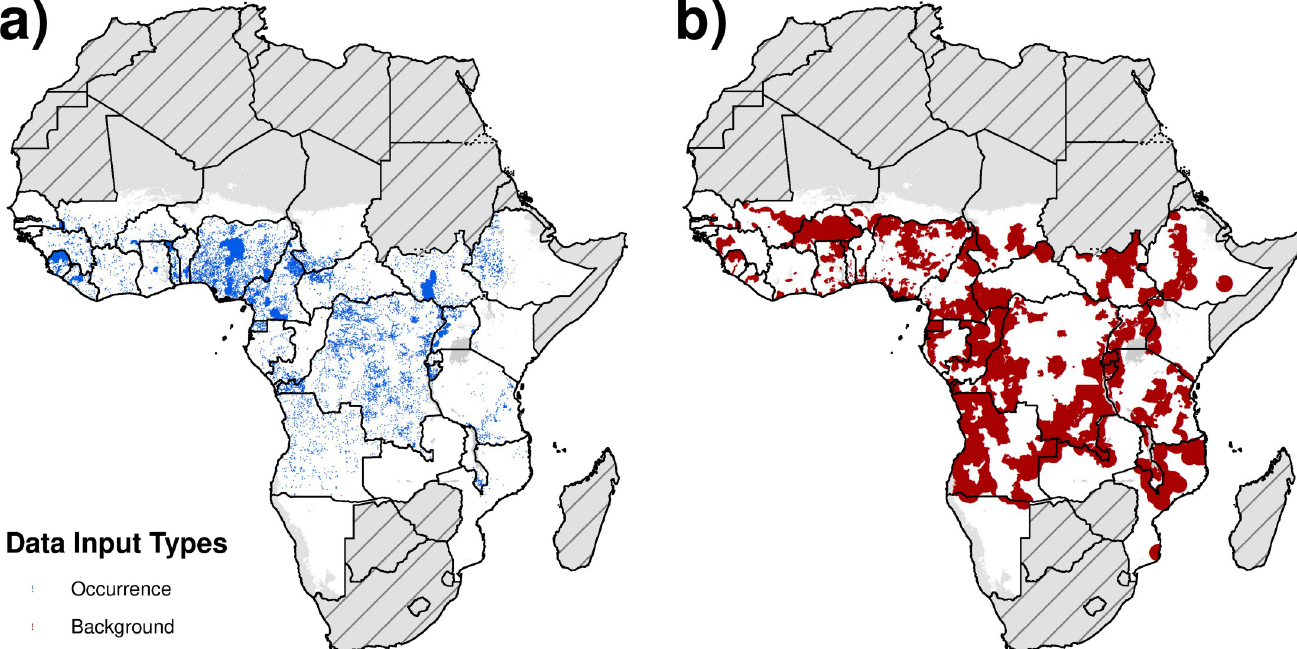
Fig 1. Location of data sources: (a) Location of occurrence data points are visualised in blue. (b) Locations chosen for the background sample are mapped in red. The background sample represents the locations chosen to compare against the occurrence data points. IUs for which endemicity status was uncertain and mapping surveys are considered were excluded from selection. Due to the density of background points chosen, they appear as polygon data in the map. Countries in grey with hatch marks were excluded from the analysis based on a review of national endemicity status. Areas in grey only represent locations masked due to sparse population. Maps were produced using ArcGIS Desktop 10.6 and shapefiles to visualize administrative units are available at https://espen.afro.who.int/tools- resources/cartography-database.